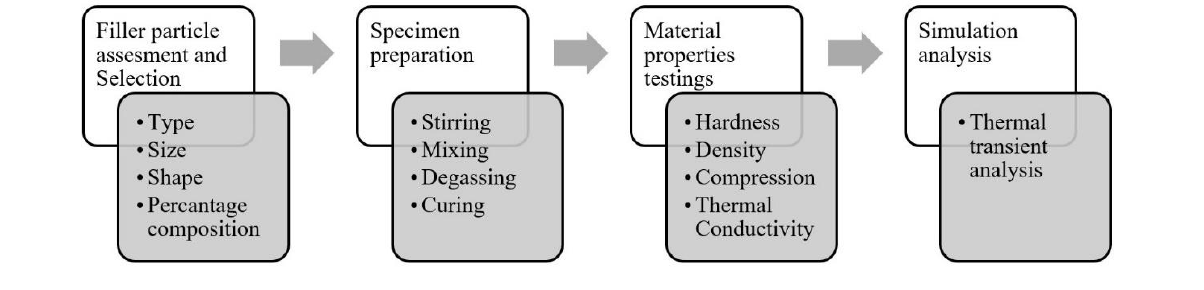
Figure 2. Flow Chart. Table 1. Filler Properties.